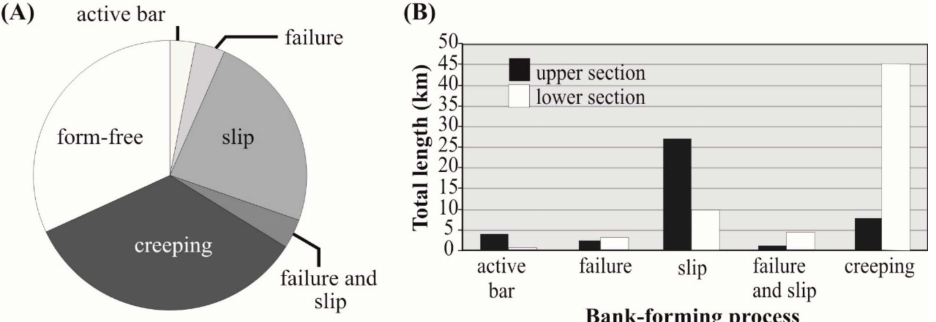
Figure 2. ( A ) Frequency of active bank processes, and ( B ) comparison of active processes along the upstream and downstream sections along the Lower Tisza.